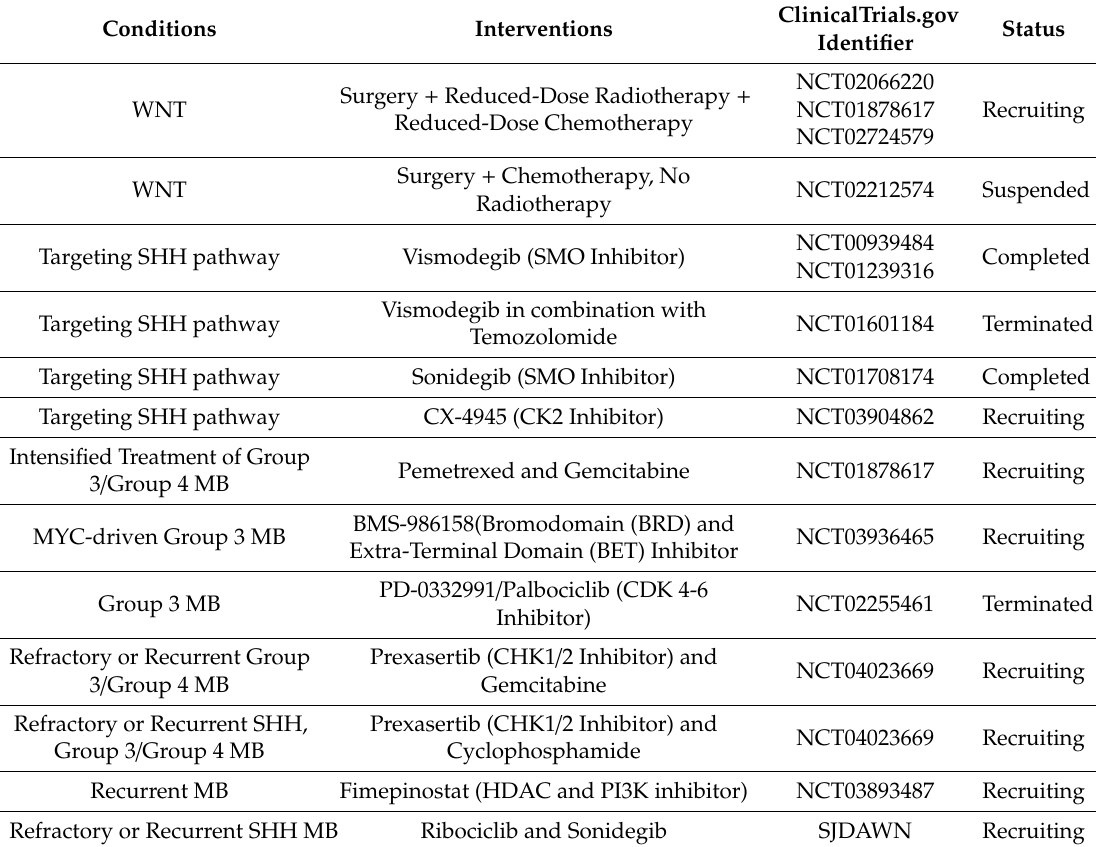
Table 3. Clinical trials targeting di ff erent medulloblastoma